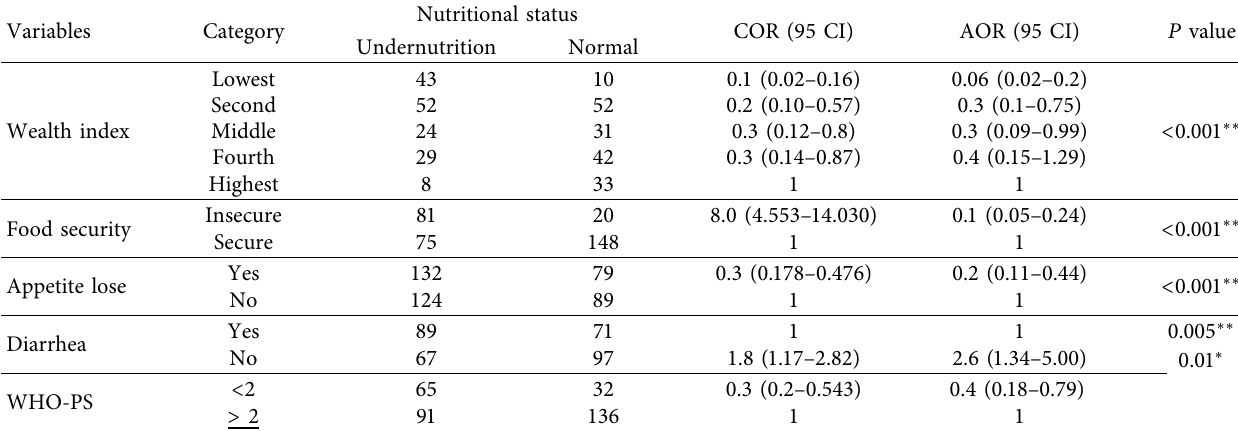
Figure 2: Symptoms of adult cancer patients undertaking chemotherapy treatment at HUCSH, Hawassa, Southern Ethiopia. Table 4: Bivariable and multivariable logistic regression of determinant factors for nutritional status among adult cancer patients under chemotherapy at HUCSH, Hawassa, Southern